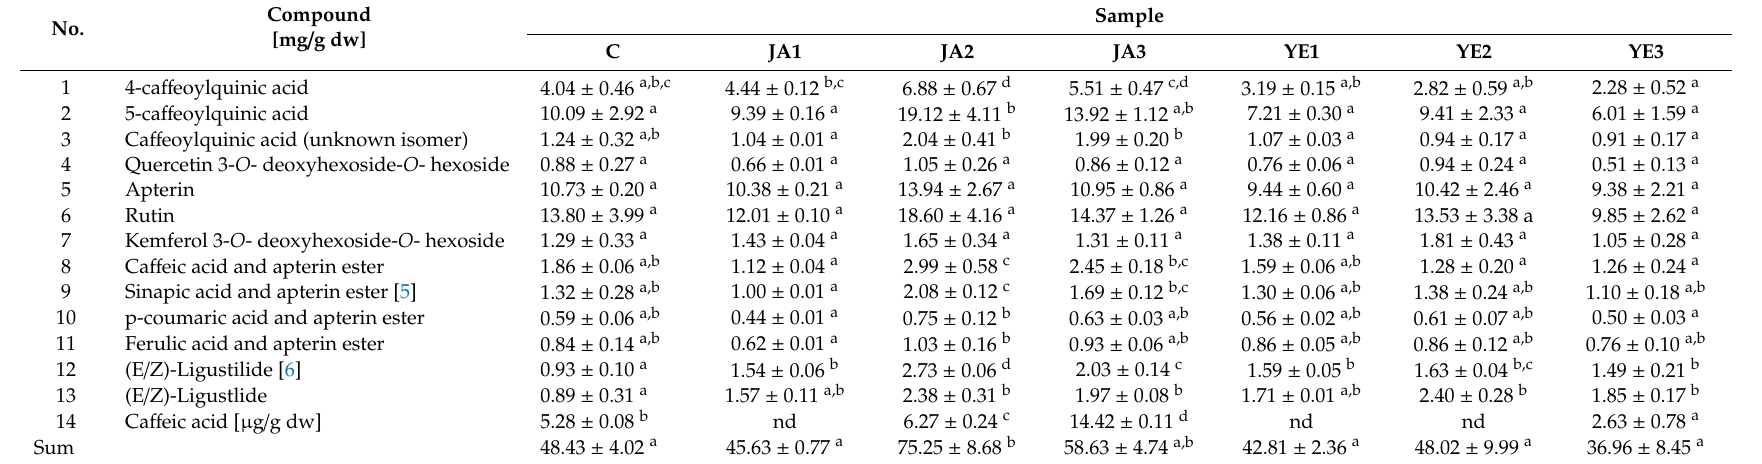
Table 1. Qualitative and quantitative analysis of phenolics in the control and elicited